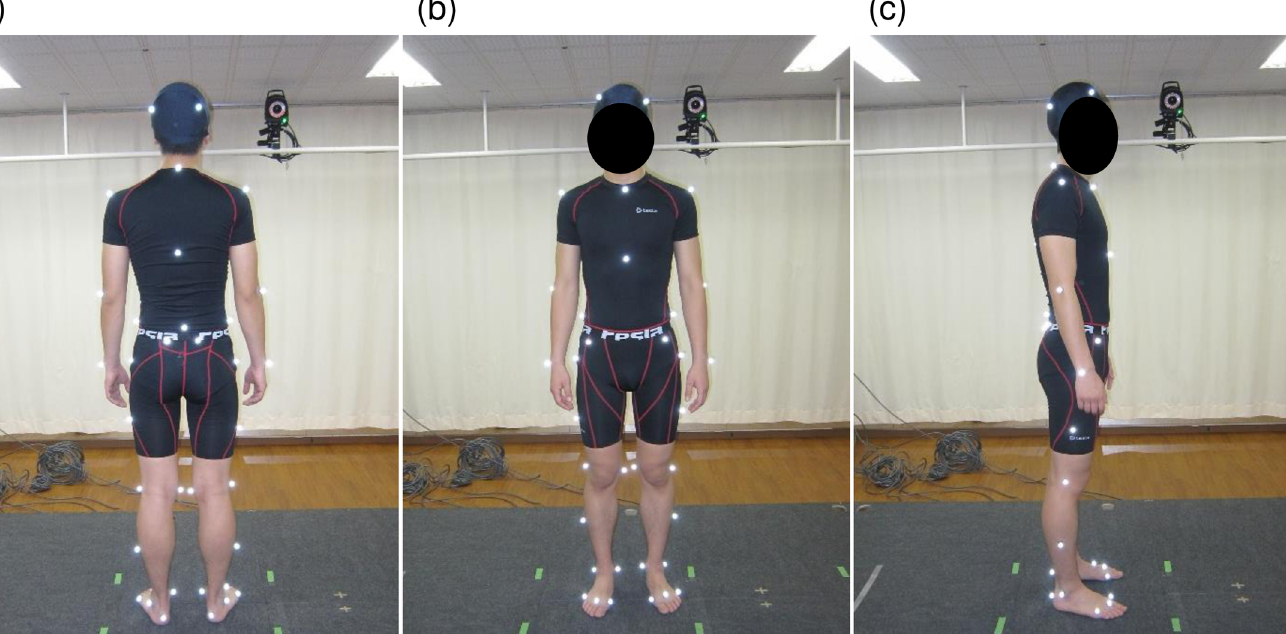
PLOS ONE | https://doi.org/10.1371/journal.pone.0197228 May 10,